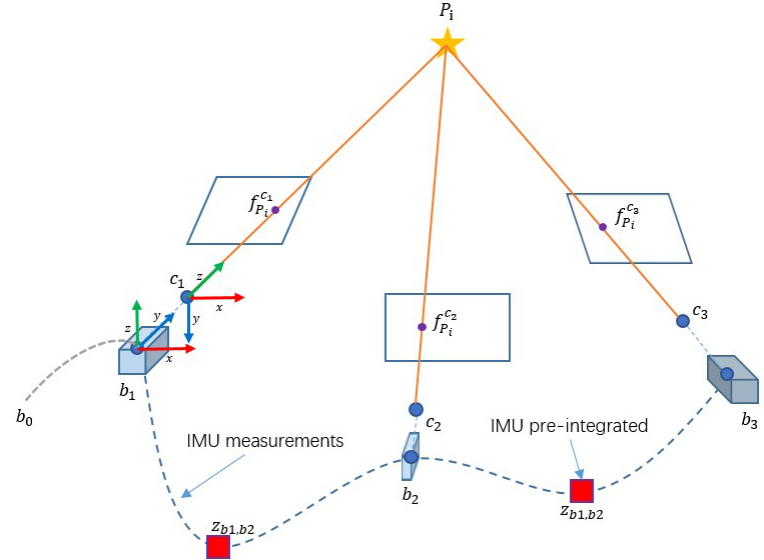
Figure 4. The process of improved stereo VIO method aided by MEMS-IMU. The inertial measurement unit (IMU) measurements are pre-integrated to predict position of feature points.